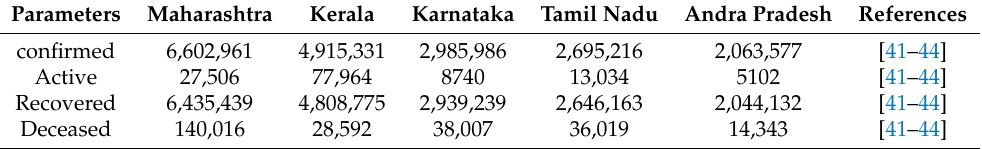
Table 5. Number of COVID-19 cases across Indian states and union territories as of 25 October 2021. Parameters